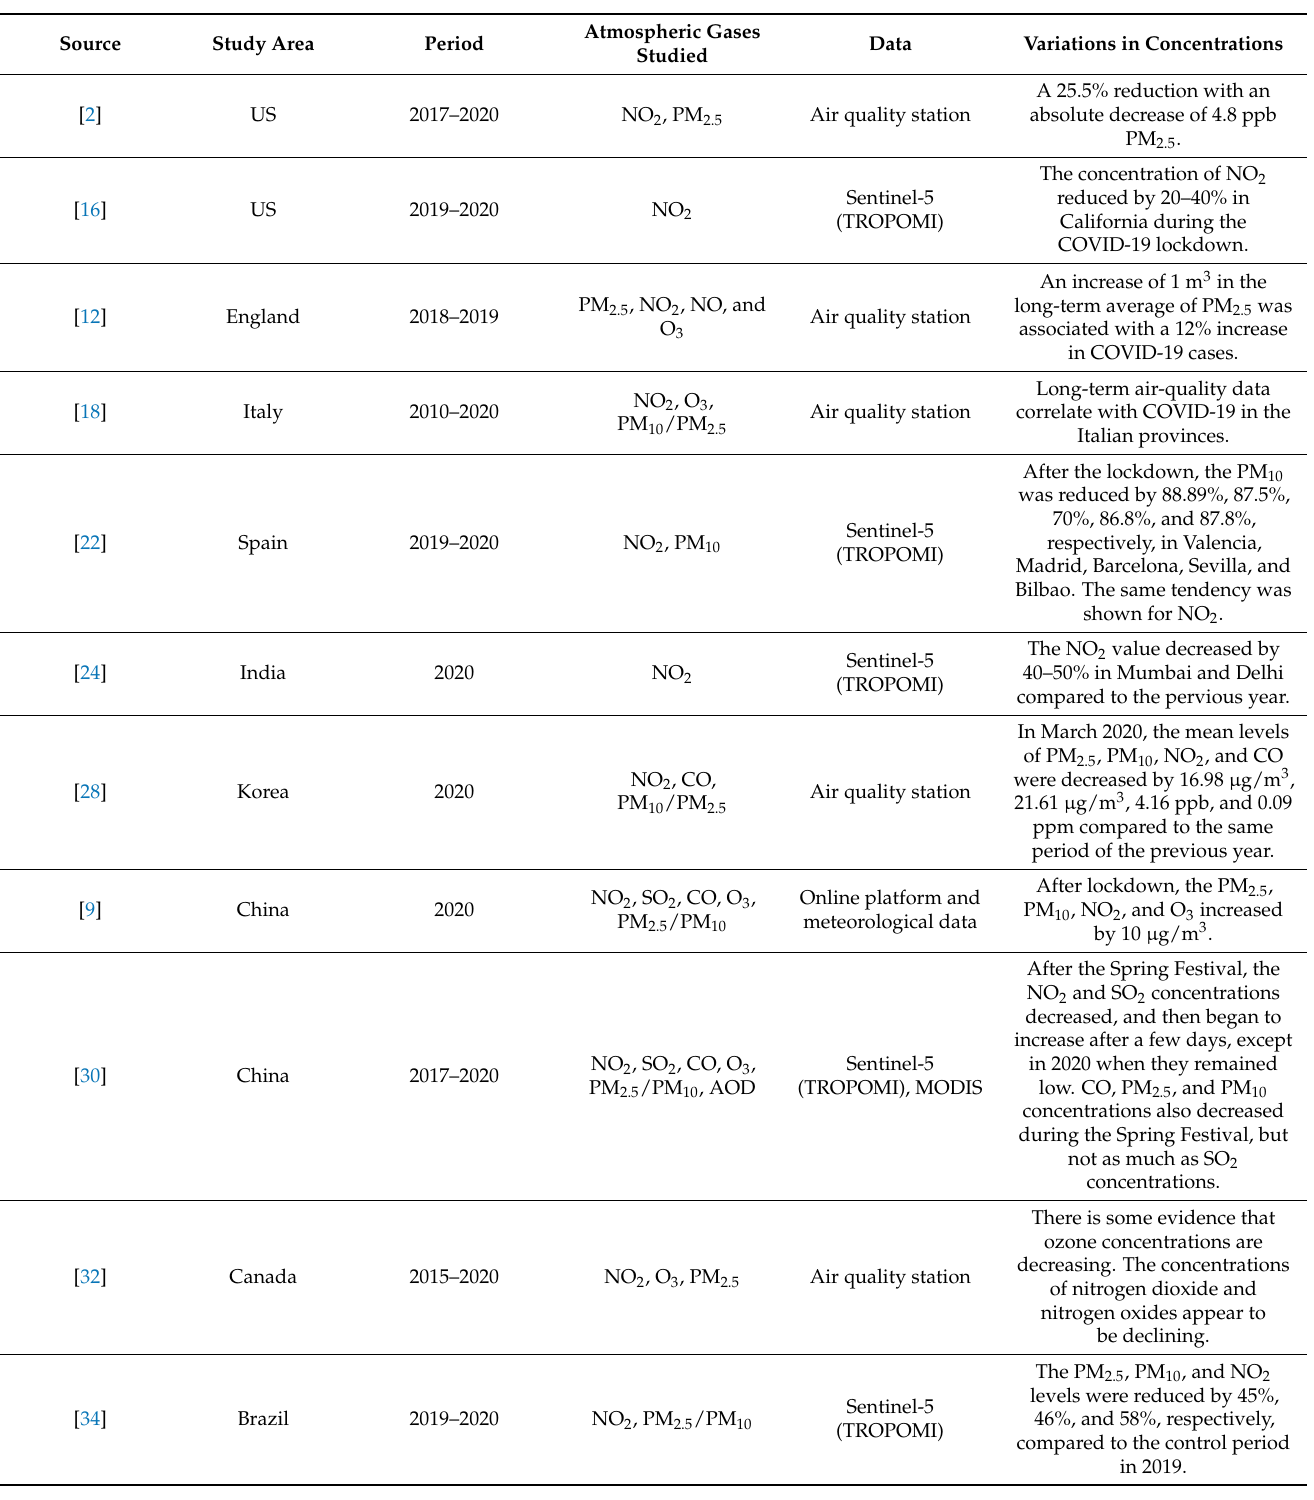
Table 1. The details of some studies on the impact of COVID-19 lockdowns on reducing air